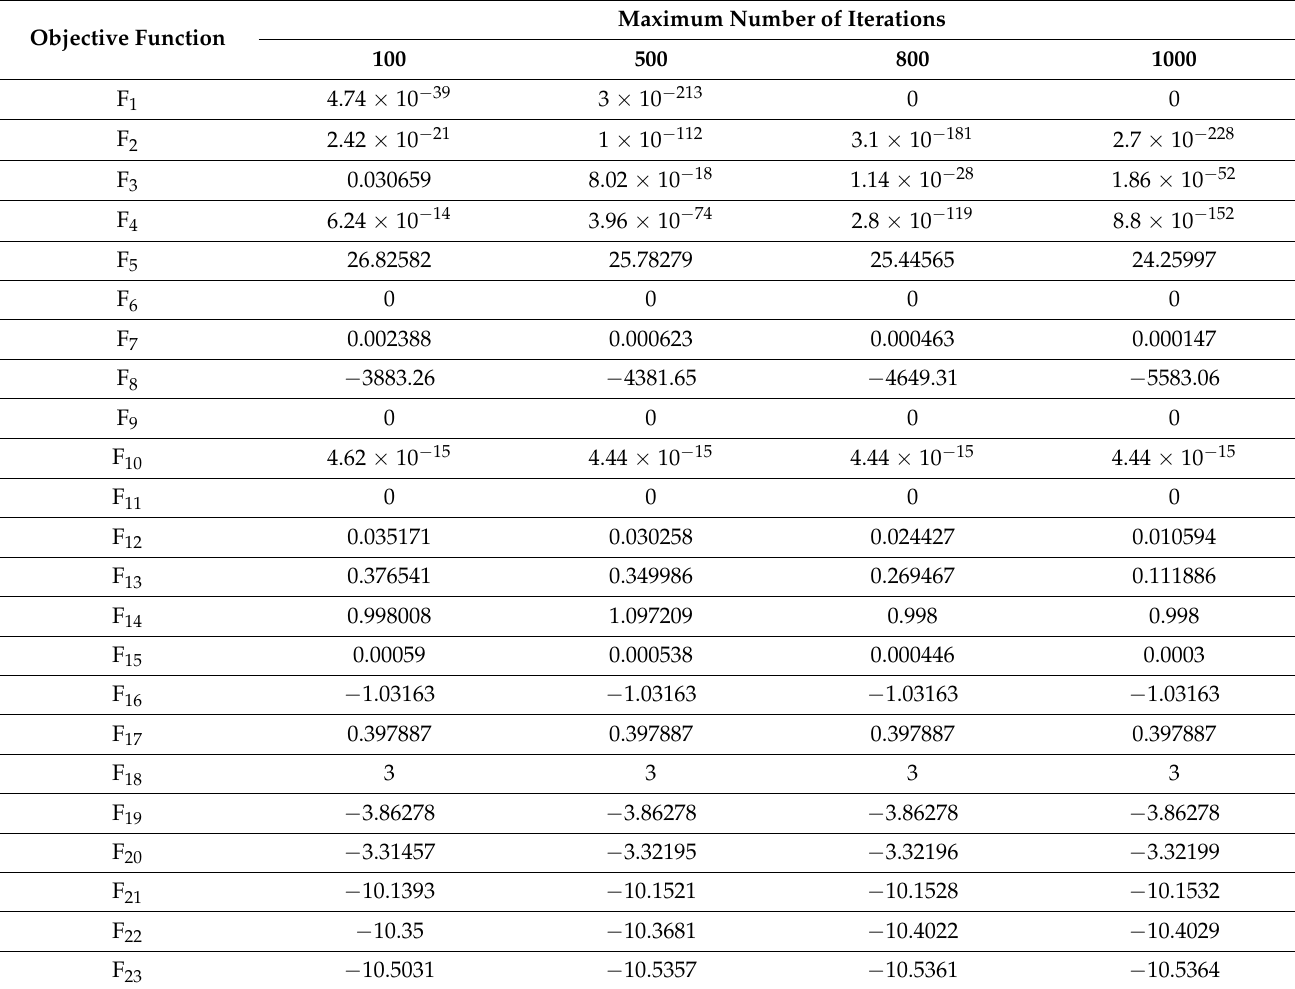
Table 6. Results of the algorithm sensitivity analysis to the maximum number of iterations.